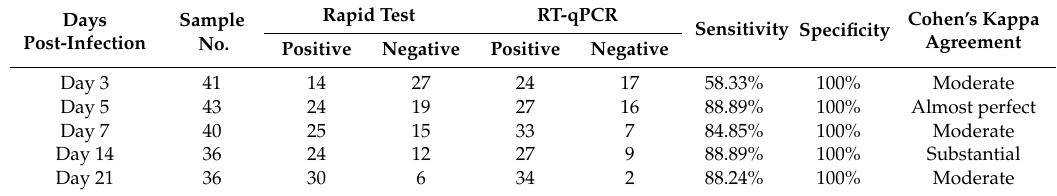
Table 1. Sensitivity and specificity of the dengue NS1 rapid test at specific days